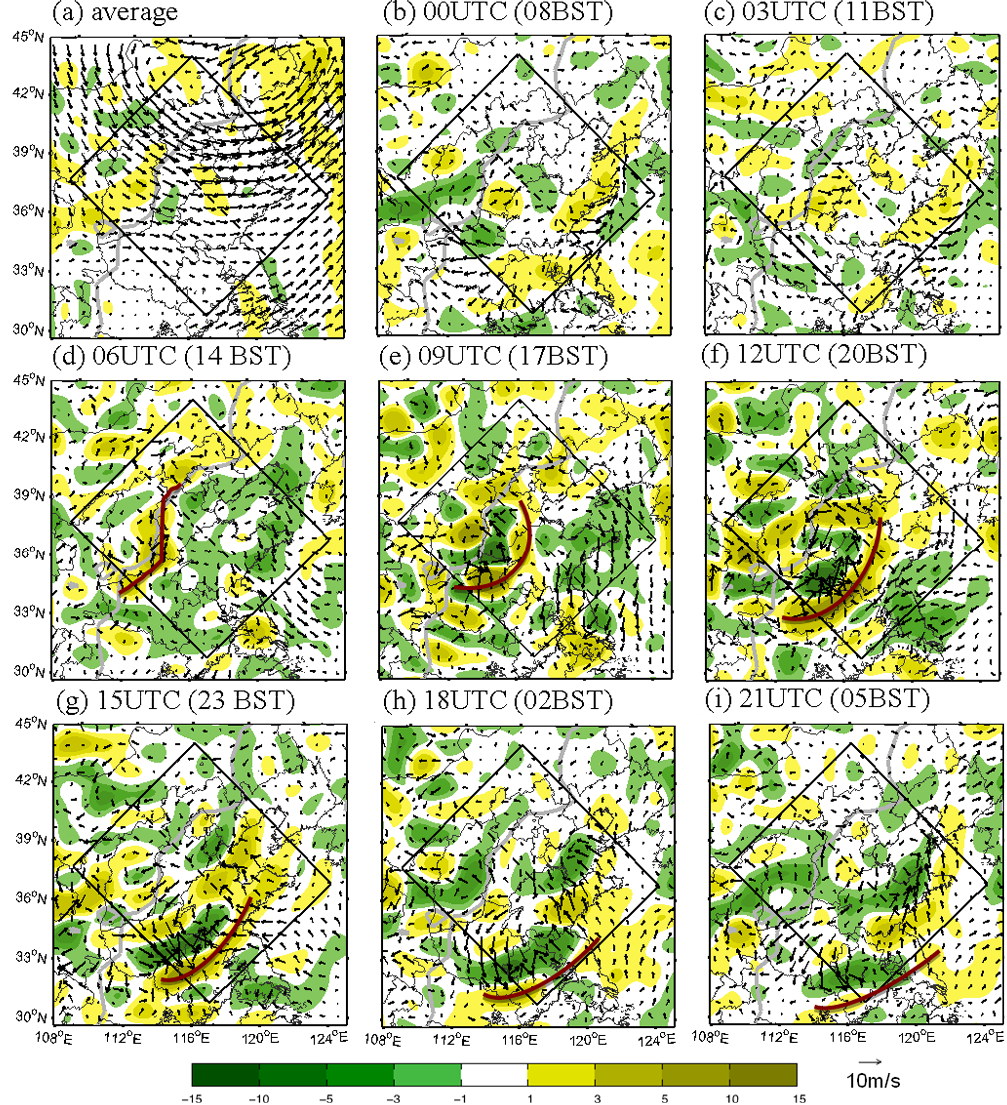
Fig. 7. (a) The average vertical velocity (shaded, cms − 1 ) and horizontal wind vectors at 3kma.g.l. for CNTL. The diurnal variation of the deviations from these averages are plotted for (b) 00:00UT; (c) 03:00UT; (d) 06:00UT; (e) 09:00UT; (f) 12:00UT; (g) 15:00UT; (h) 18:00UT; (i) 21:00UT. The thick maroon line denotes the location of the phase fronts of the